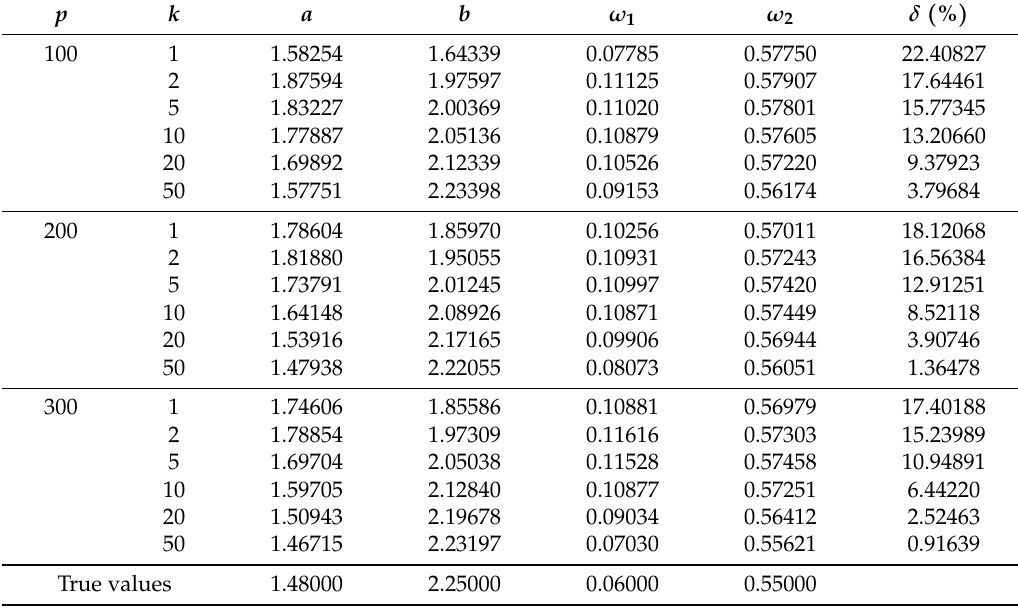
Table 3. The MDW-GI parameter estimates and errors ( σ 2 = 0.50 2